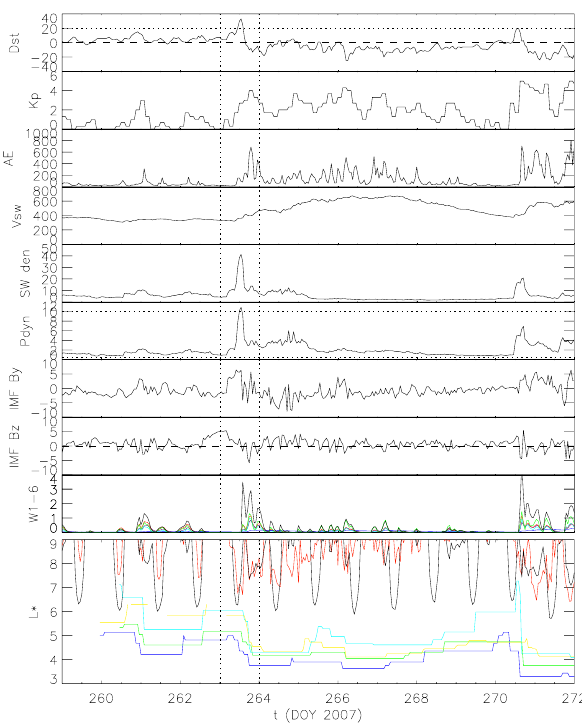
Figure 1. Interplanetary and magnetospheric quantities for a time interval surrounding 20 September 2007. Top to bottom: Dst, Kp, solar wind velocity, solar wind density, solar wind dynamic pres- sure, IMF B y , IMF B z , and the integrated quantities W 1 – W 6 (ma- genta, red, blue, cyan, green, and black, respectively) used the T04 magnetic field model. The final panel shows the last closed drift shell computed according to the T04 magnetic field model (black) and the T96 model (red). Also shown in the final panel is the plasmapause location according to several models as described in Sect.